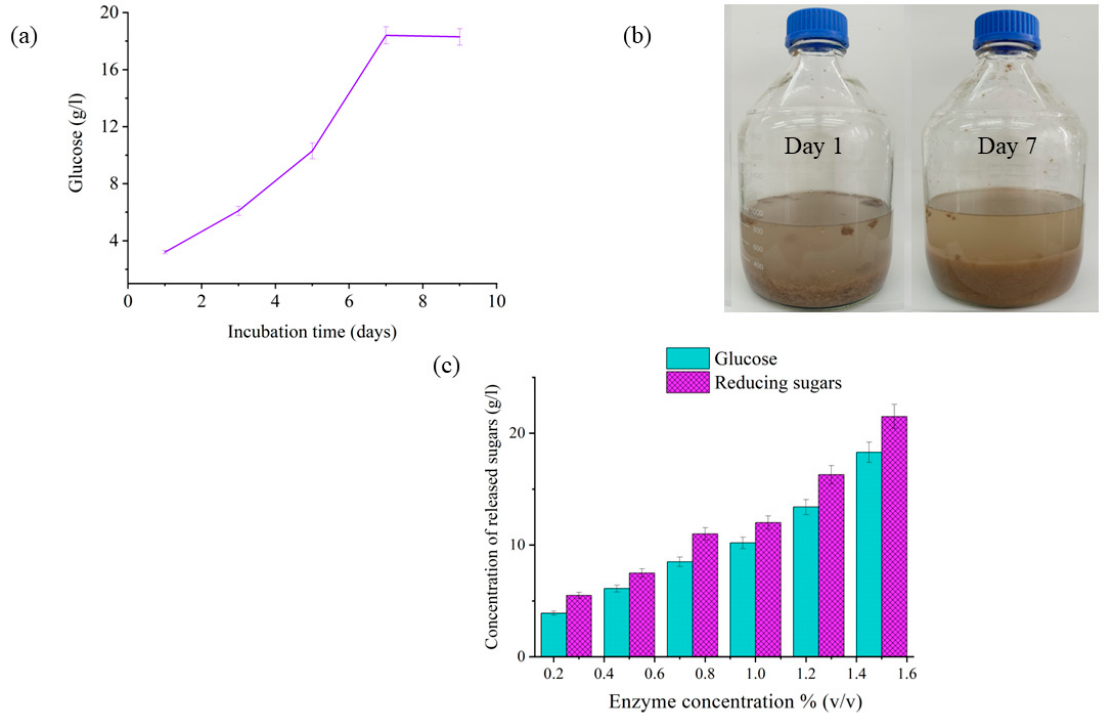
Figure 1. Enzymatic hydrolysis of cardboard, ( a ) Incubation time effect on the hydrolysis process, ( b ) presentation of the enzymatic hydrolysis process on cardboard fibers on the 1st and the 7th day and ( c ) colorimetric analysis of the enzymatic hydrolysis products, including reducing sugars and glucose.